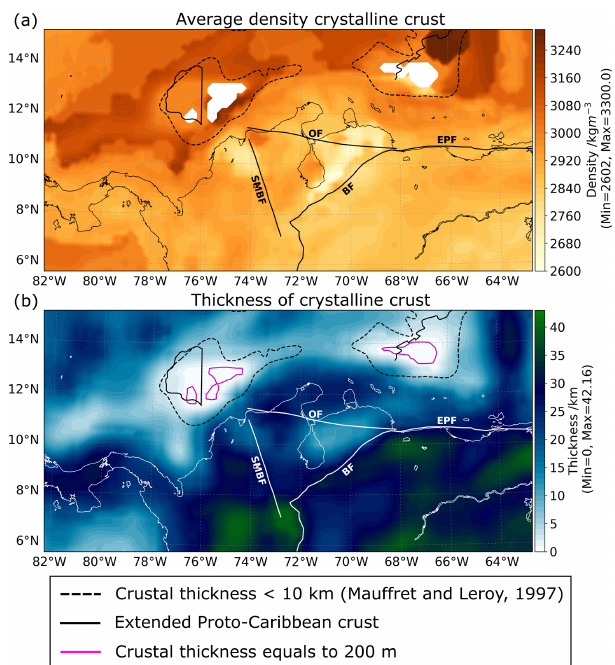
Figure 9. The average density of the crystalline crust obtained after forward-modelling the gravity residuals highlights areas where the high-density material of the C-LIP formation strongly affected the Proto-Caribbean crust. (a) Average density of the South Caribbean and north-western South American crusts based on the forward- modelling of the gravity residuals. The crustal domains summarized in Table 2 have been included. White domains represent areas were the thickness of the oceanic crust is virtually zero, according to the integrated datasets. (b) Thickness of the crystalline crust used in the data-integrative 3D model (see Sect. 3.1). Magenta polygons are contours of 200m thickness. Other polygons as depicted in Fig. 10. Acronyms are the same as in Fig. 1.